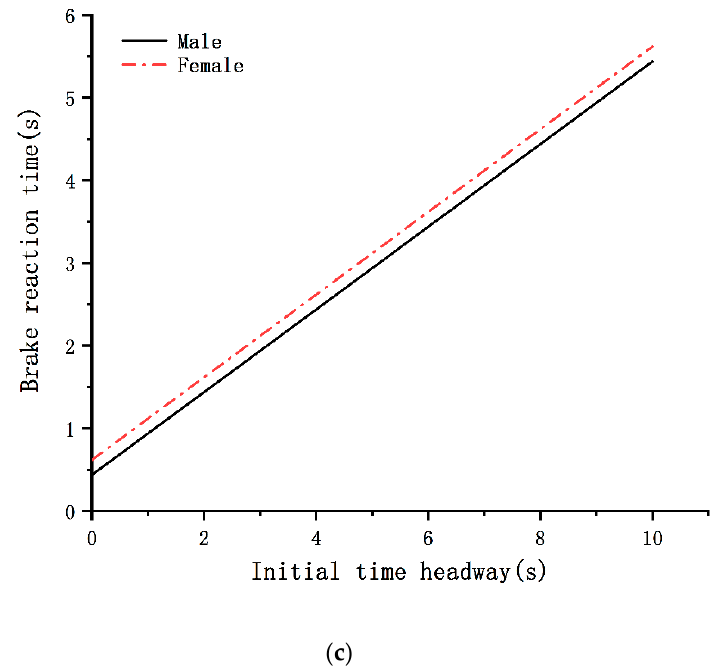
Figure 3. Relationship between the drivers’ brake reaction time (BRT) and the significant variables. ( a ) Non-distracted driving, male, initial time headway (ITHW) = 1 s; ( b ) male, initial speed = 15 m / s, LV deceleration rate = 8 m / s 2 ; ( c ) non-distracted driving, initial speed = 15 m / s, LV deceleration rate = 8 m / s 2 .